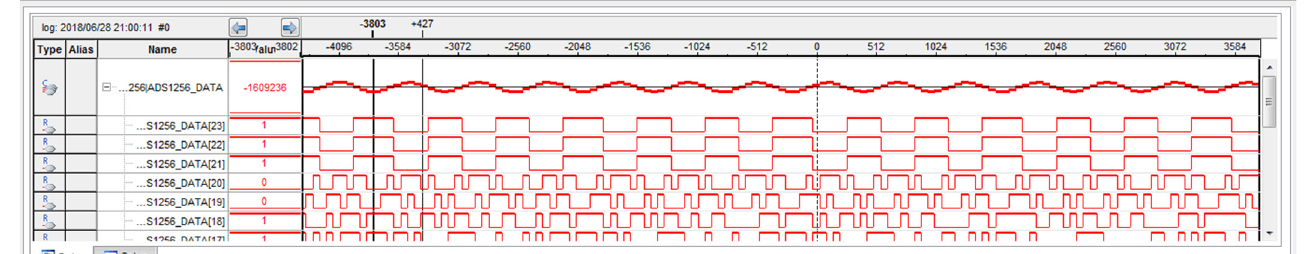
Figure 18. The signal collected by FPGA is displayed in SignalTap.